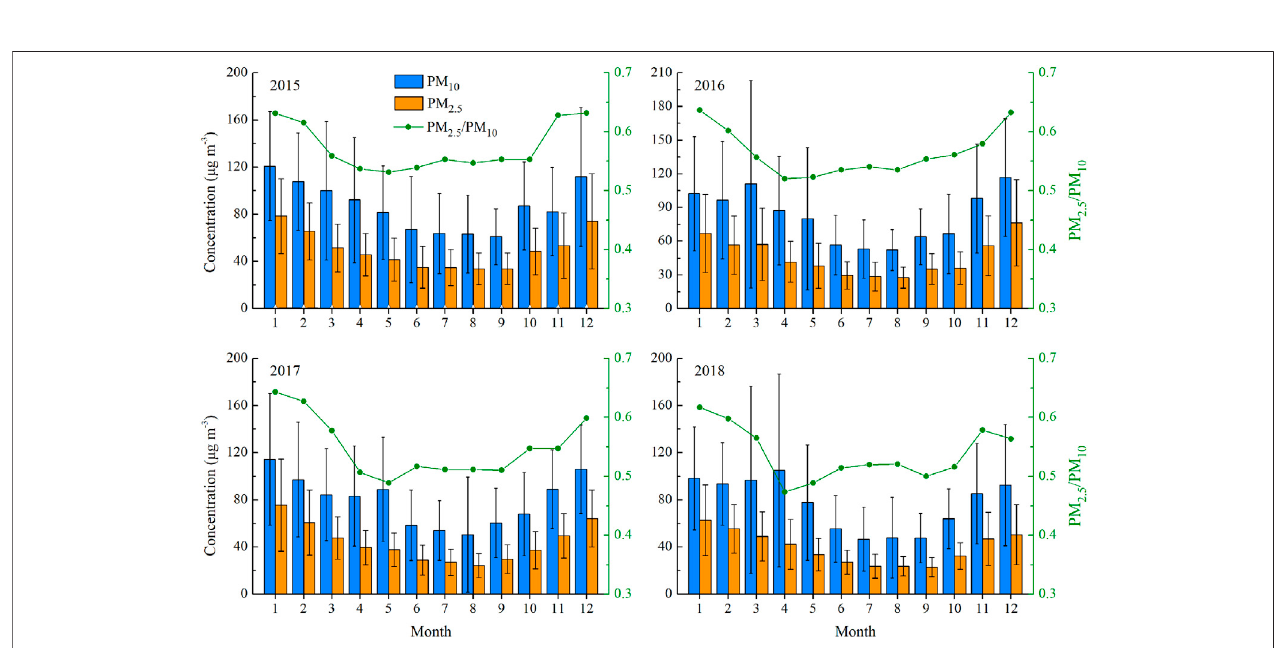
FIGURE 4 | The monthly variation of average PM concentrations (PM 2.5 and PM 10 ) and PM 2.5 /PM 10 ratios obtained from all national stations in 2015, 2016, 2017 and 2018.